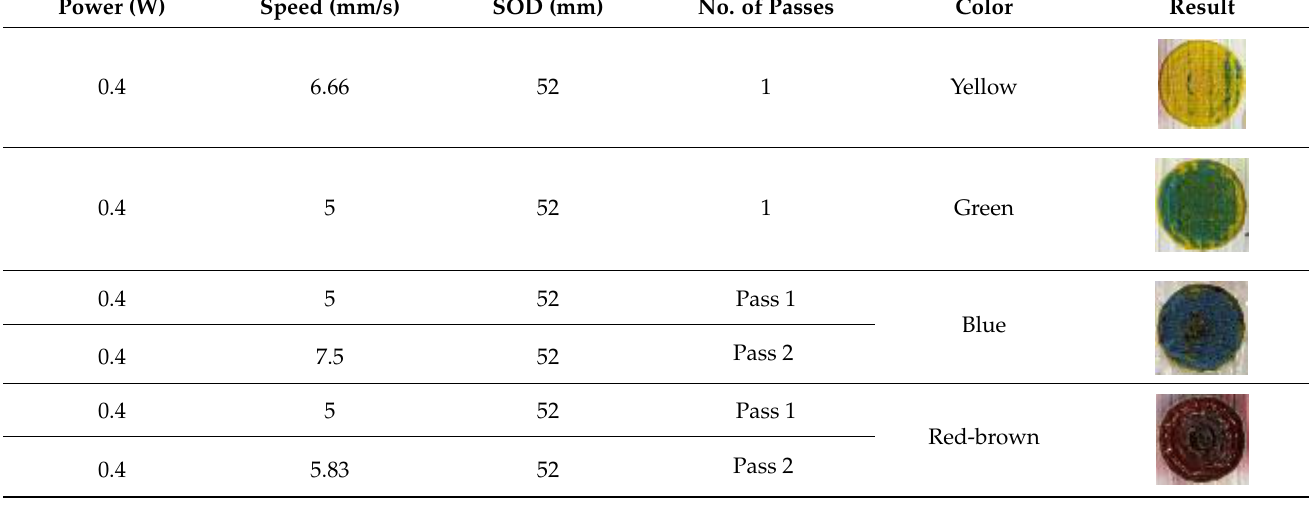
Table 4. Optimum laser processing parameters to obtain yellow, green, blue, and red-brown colors.